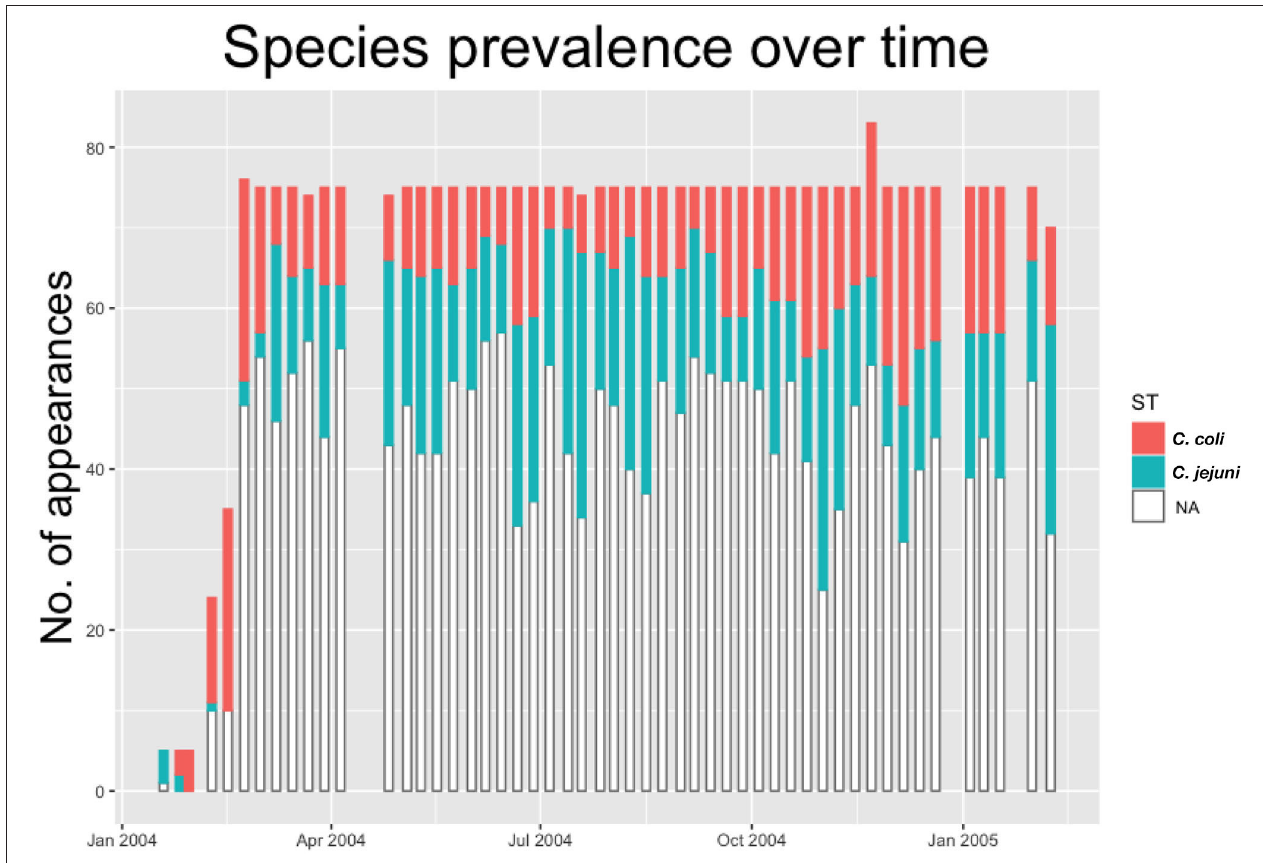
FIGURE 1 | Histogram showing the count of positive and negative samples from a breeder flock for different species of Campylobacter . White “NA” counts represent samples that were negative for Campylobacter